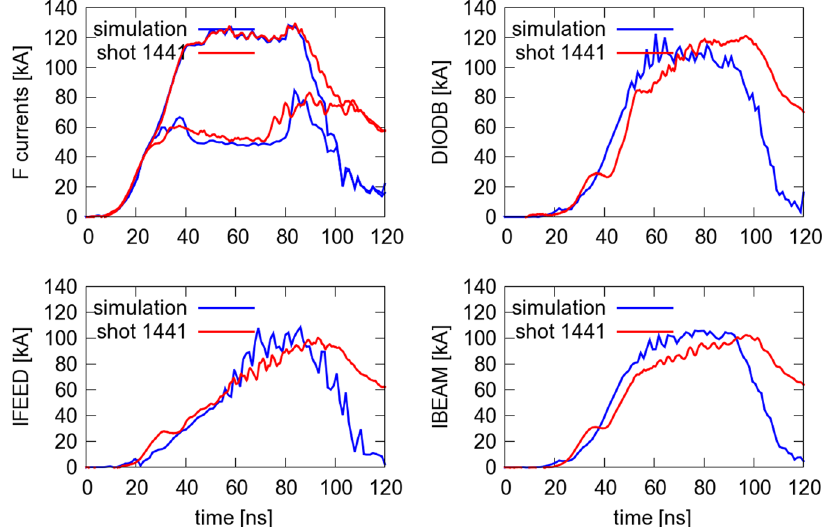
FIG. 7. Currents in the MITL, dustbin, and diode from a simulation of shot 1441 compared to data. The diode has a 7-mm diameter needle and a 7-mm AK gap.